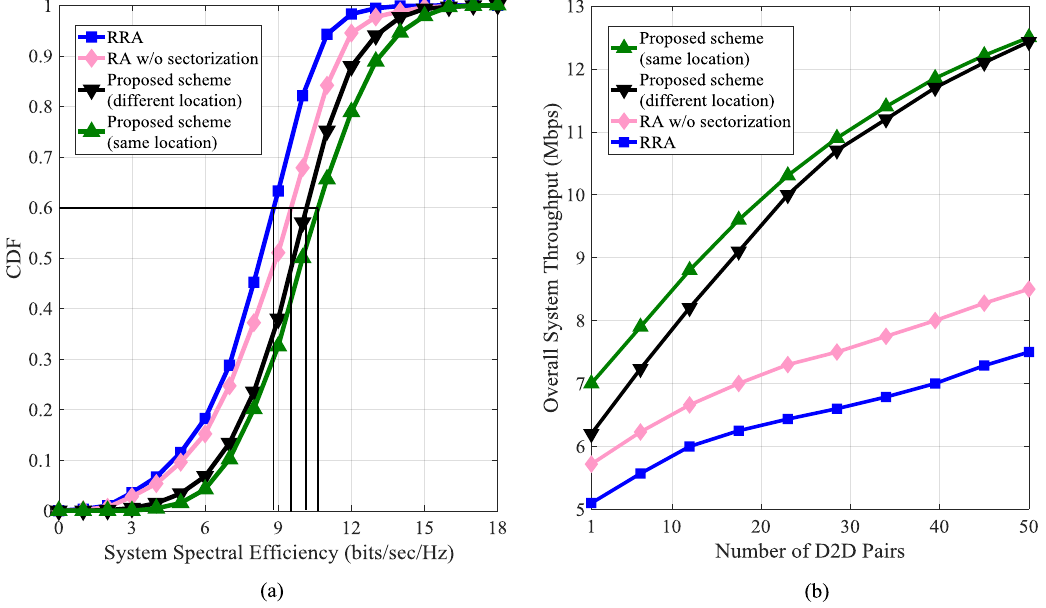
Figure 10. ( a ) System spectral efficiency vs. CDF and ( b ) overall system throughput with varying number of D2D pairs in the same and different locations.